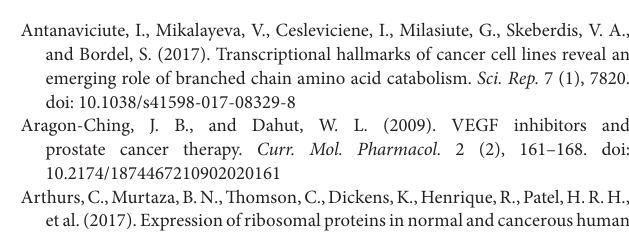
SUPPLEMENTARY FIGURE 1 | Venn diagram of enrichment results obtained through pathfindR analyses with all available PINs. SUPPLEMENTARY FIGURE 2 | Venn diagram of the numbers of direct interactions of input genes in each PIN. SUPPLEMENTARY DATASHEET 1 | The results of differential expression analyses for RA, CRC and PCa, prior to filtering (differential expression statistics for all probes) and after filtering (lists of DEGs). SUPPLEMENTARY DATASHEET 2 | The unfiltered results of enrichment analyses using all the different methods on each of the datasets. SUPPLEMENTARY DATASHEET 3 | ORA results using all DEGs and using only DEGs found in the BioGRID PIN for each